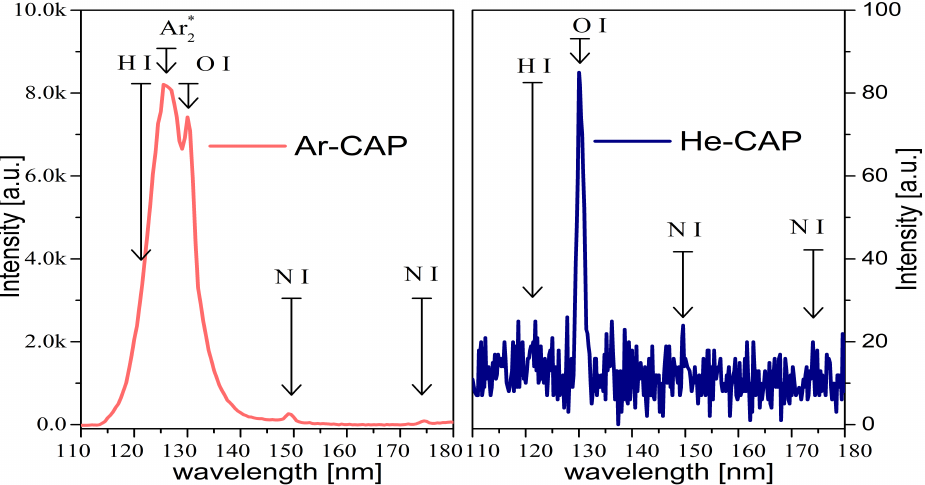
Figure 9. VUV spectra of the discharge in argon ( left ) and helium ( right ) for an applied voltage of 8 kV pp and a distance to the MgF 2 window of 4 mm. Ar-CAP generated a spectral radiance of up to 350 mW/(nm mm 2 sr) at around 125